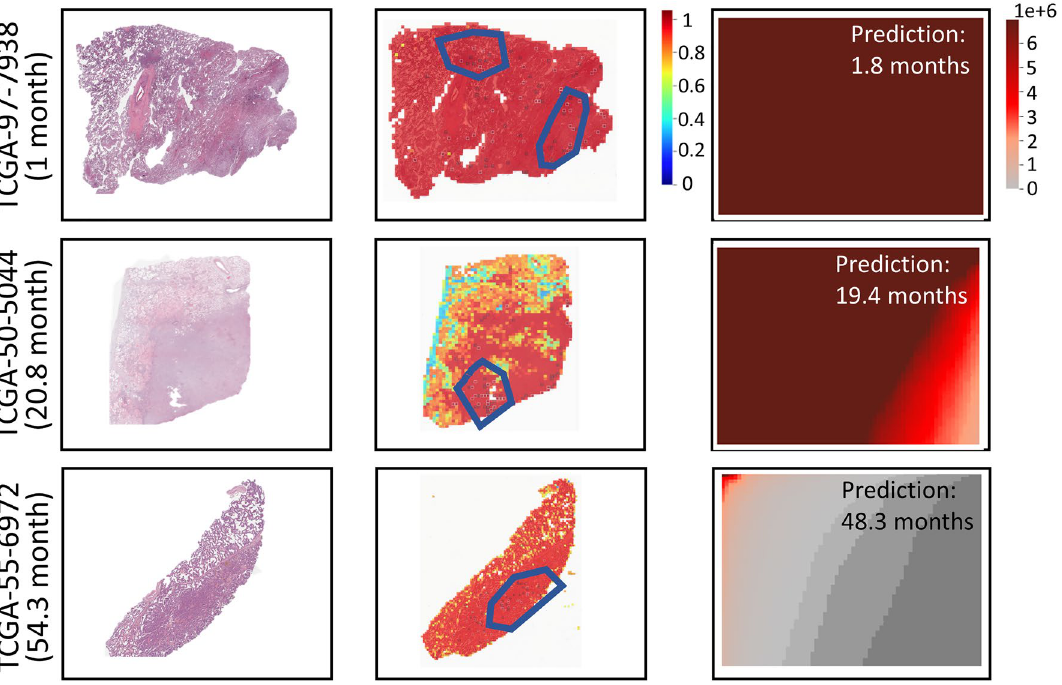
Figure 12. The original WSIs (left), patch-wise probability maps (middle), and HipoMaps (right) of the three patients, who survived one month (TCGA-97-7938), 20.8 months (TCGA-50-5044), and 54.3 months (TCGA- 55-6972) in TCGA-LUAD.